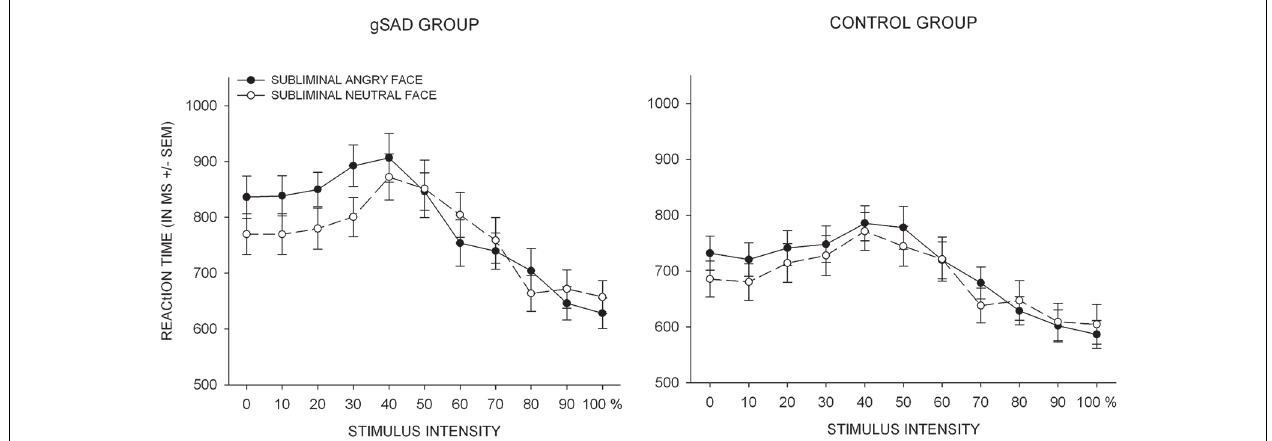
FIGURE 3 | Reaction time latencies for the perceptual judgment task. Reaction times are plotted against stimulus intensity ranging from neutral (0) to angry (100).The dark circles and solid lines represent an angry subliminal